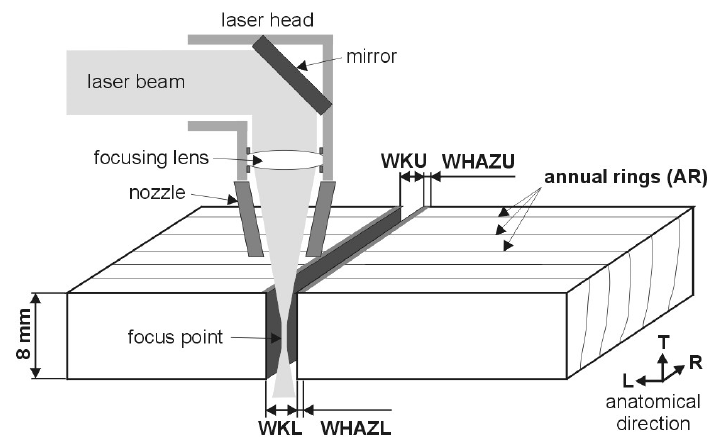
Figure 1. Cutting